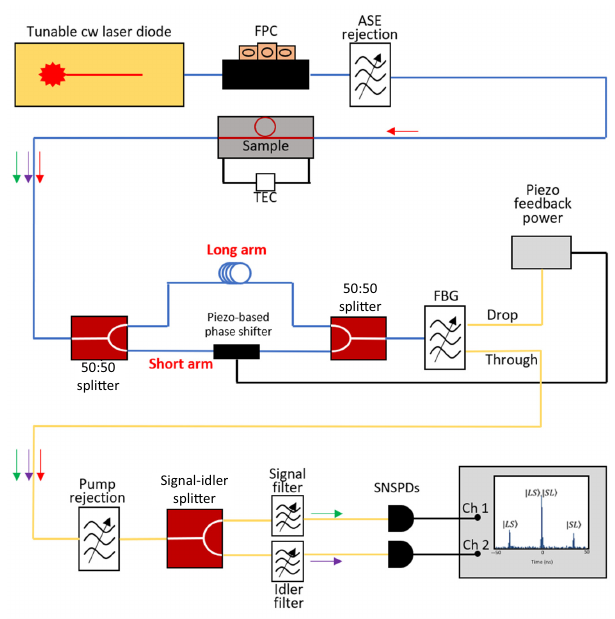
FIG. 6. A schematic of the experimental setup for a fiber-based folded Franson-type interferometer. The tunable cw laser diode is swept and held at the resonance wavelength of the microring res- onator. The laser is sent through amplified-spontaneous-emission (ASE) rejection filters and coupled via lensed fiber onto and off of the photonic chip. The light is split into a short and a long arm of an interferometer. A piezo-based phase shifter is used to mod- ify the phase of the photons that travel through the long arm. The pump photons are removed via an FBG and filters on the signal and idler channels. The signal and idler channels are coupled to SNSPDs to determine the count